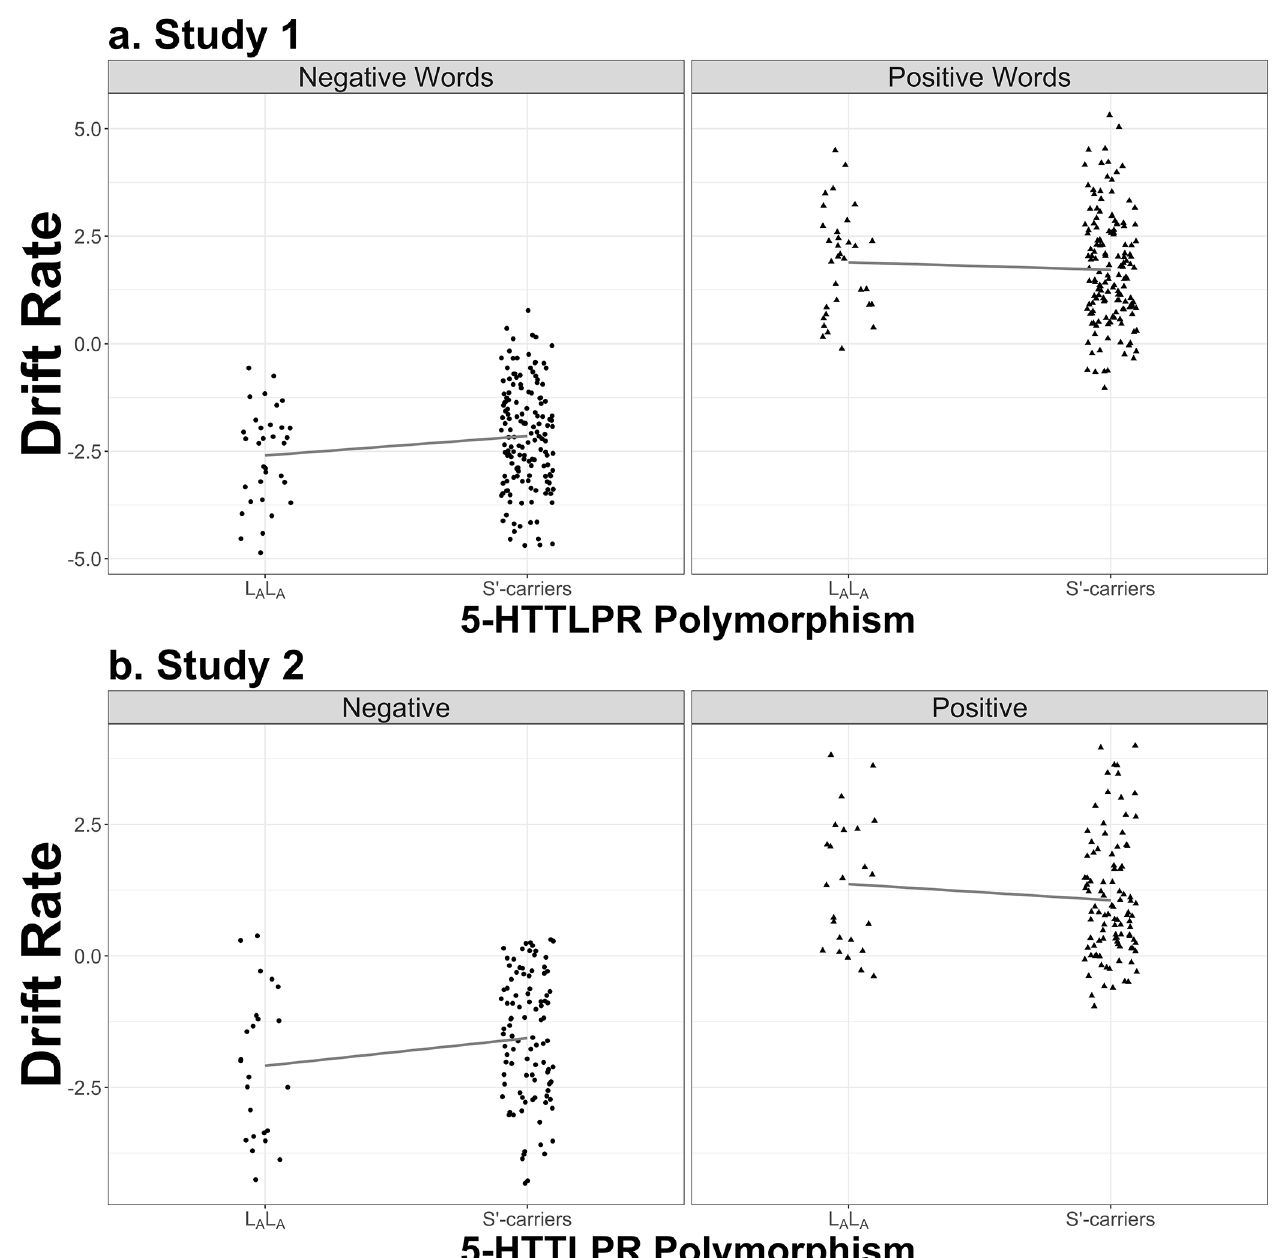
Fig 2. Association between 5-HTTLPR and drift rate for the self-referent encoding task. The top set of plots (a) show data from Study 1; the bottom set (b) show data from the replication, Study 2. The left plot shows the relationship between the 5-HTTLPR genotype and drift rate for negative adjectives and the right plot shows the relationship between the 5-HTTLPR genotype and drift rate for positive adjectives. The left plot shows that S 0 -carriers of the 5-HTTLPR polymorphism displayed a larger (less-negative) drift rate, indicating that they had more difficulty categorizing negative words as not self-referential. Points are jittered to so that all observations are